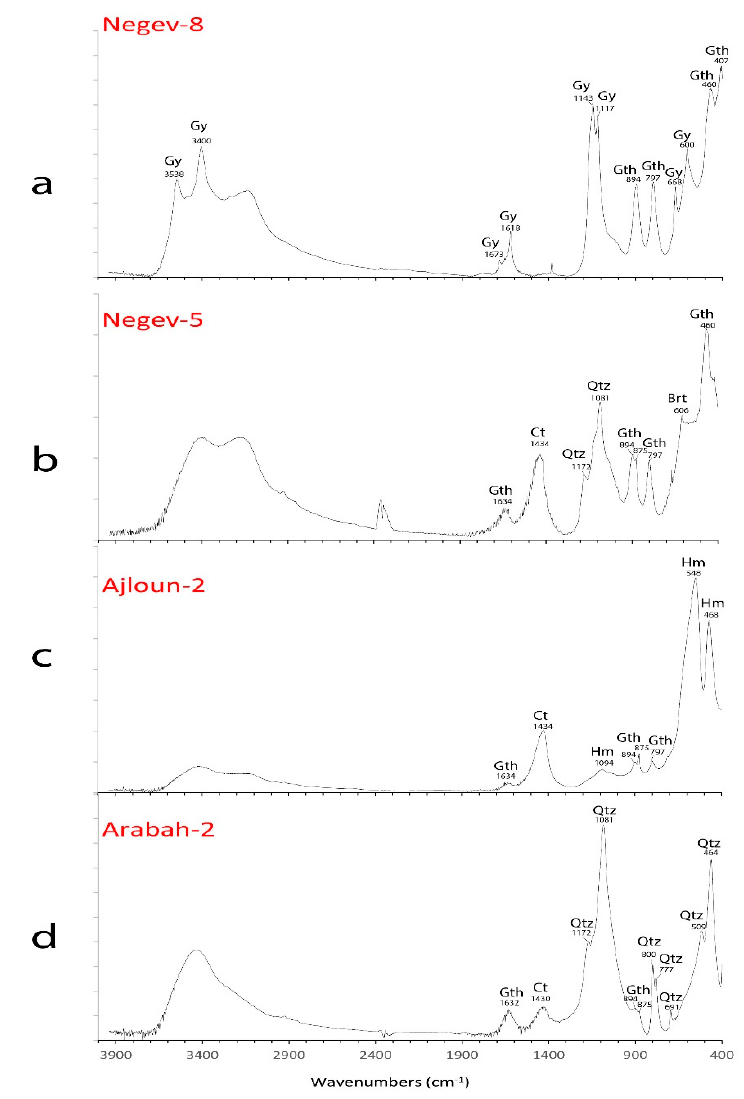
Figure 5. Examples of FTIR spectra of some analyzed iron ore samples with peaks corresponding to specific minerals: ( a ) Negev-8. Ore dominated by goethite (Gth) with some amount of gypsum (Gy); ( b ) Negev-5. Ore dominated by goethite with some amount of barite (Brt) and quartz (Qtz); ( c ) Ajloun-2. Ore dominated by hematite (Hm), with some amount of goethite and calcite (Ct); ( d ) Arabah-2. Ore of goethite, with significant amount of quartz and minor amount of calcite.